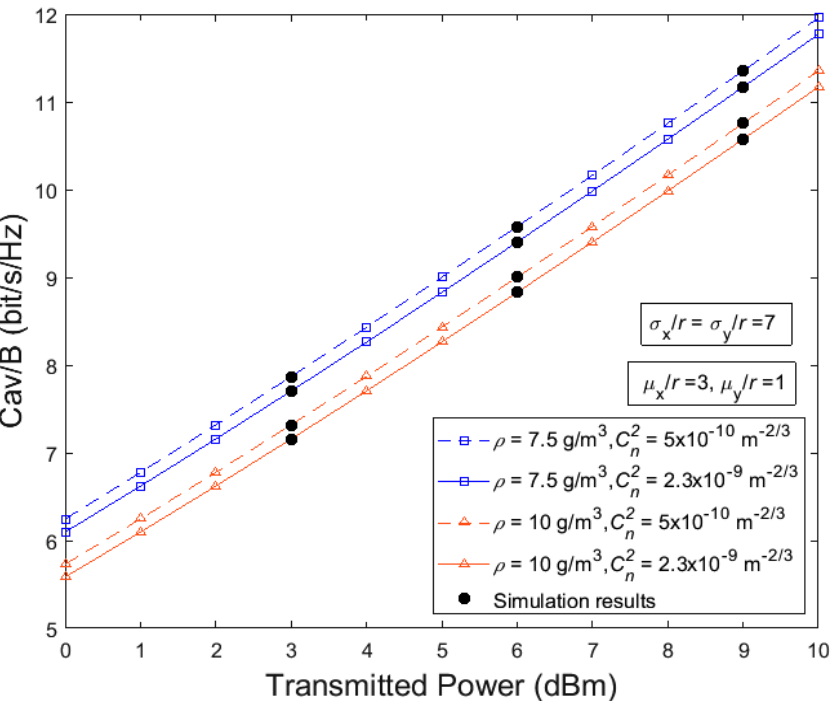
Figure 2. Average capacity (C av /B) versus transmitted power under clear weather, weak to strong turbulence, moderate to strong water vapor concentration, and strong NZB PE.